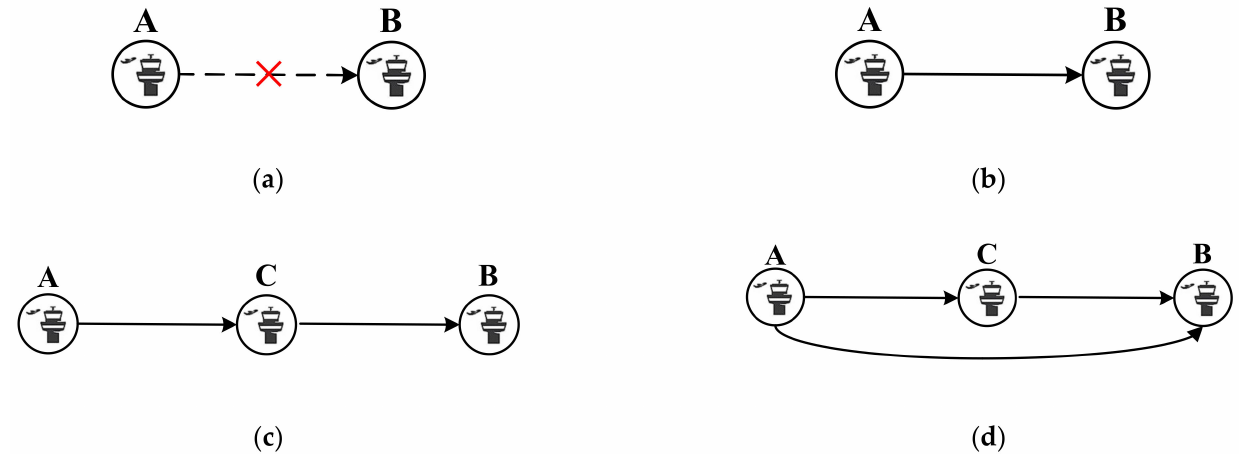
Figure 1. Airport delay propagation causality. ( a ) No causation; ( b ) Direct causation; ( c ) Indirect causation; ( d ) Both direct and indirect